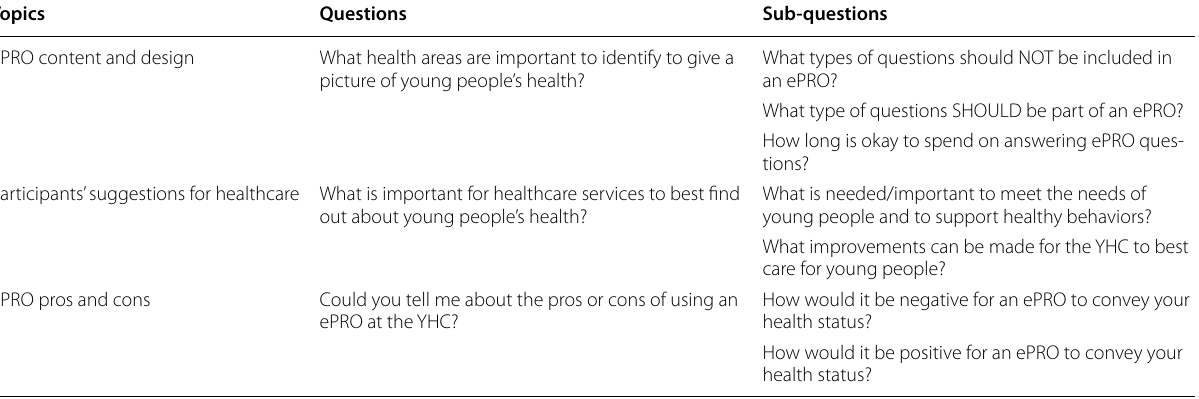
Table 1 Interview guide topics and questions used to investigate participants’ views on electronic patient-reported outcome (ePRO) at youth health clinics (YHCs)